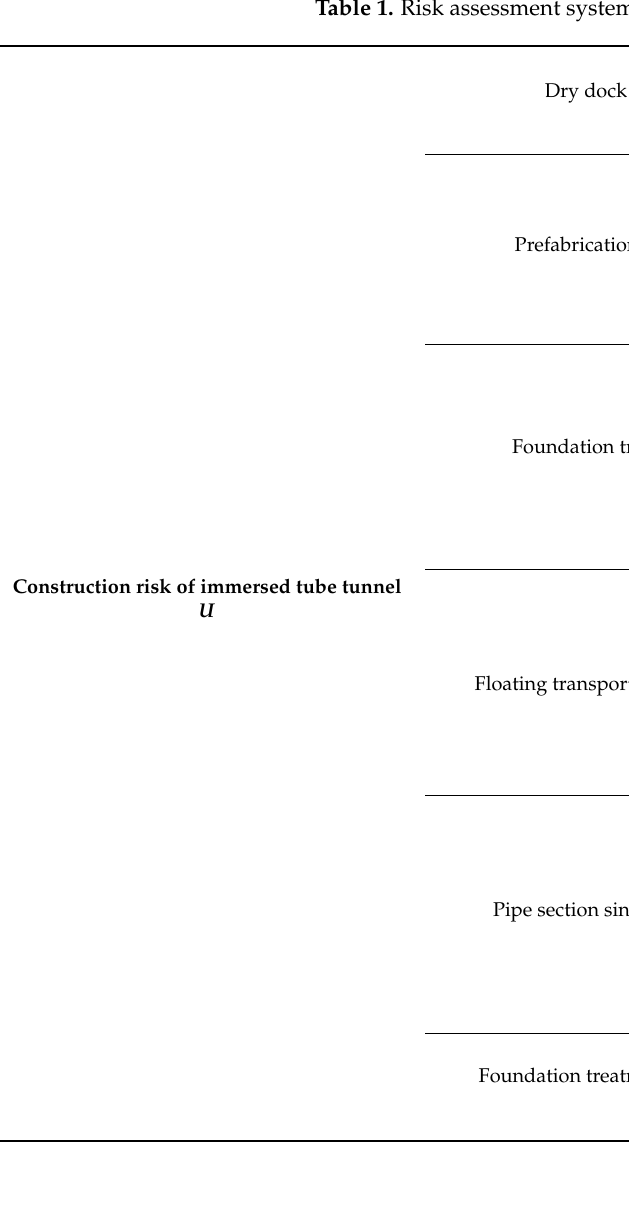
Table 1. Risk assessment system of immersed tube tunnel